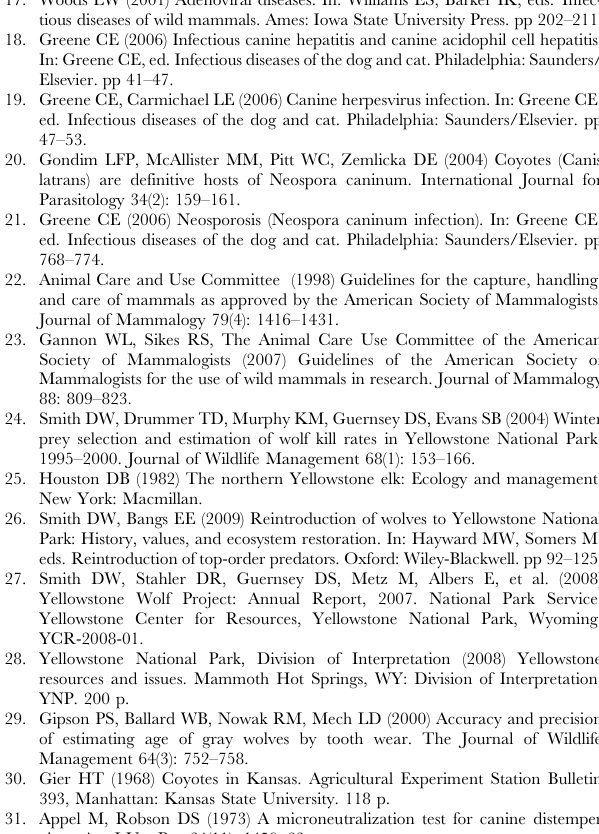
Table S1 Epidemiological characteristics of selected canid pathogens. Data are largely based on the study of domestic dogs. Table S2 Models of disease seroprevalence and survival considered and evaluated for Yellowstone National Park’s canids. Response variables include seroprevalence of canine parvovirus (CPV), canine adenovirus (CAV-1), canine herpesvirus (CHV), Neospora caninum (Neo), and canine distemper virus (CDV), as well as wolf-pup survival (Survival). Covariates are detailed in Table 1, but include Year, Location (Northern Range versus Interior; wolves only), Resident (resident versus transient status; coyotes only), and AgeClass (juvenile, young adult, or old adult). (K = number of estimable parameters, increasing differences from the best model ( h ) indicate decreasing model adequacy, and Akaike weights (w) express model support relative to all other models in the set. Additive effects are expressed with a plus sign, and interactions between factors are connected with an asterisk.)